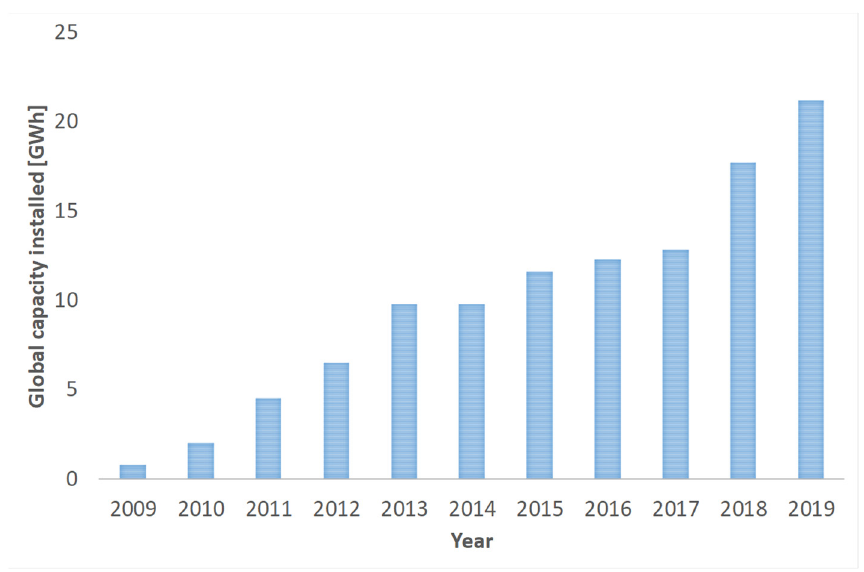
Figure 4. CSP thermal energy storage global capacity [GWh] installed per year. Adapted from [3]. Countries that are researching this topic are shown in the heat map in Error! Refer- ence source not found. . The top countries are highlighted in Error! Reference source not found. . In this case, Europe was considered a single territory covering the member states in the EU27. Up to 2021, the countries of the European Union were leading all the territo- ries with the most documents (122), followed by the USA (63 publications), China (with 39), and Chile (17). Within the European Union, Spain and Germany had the highest num- ber of documents published (57 and 47, respectively).